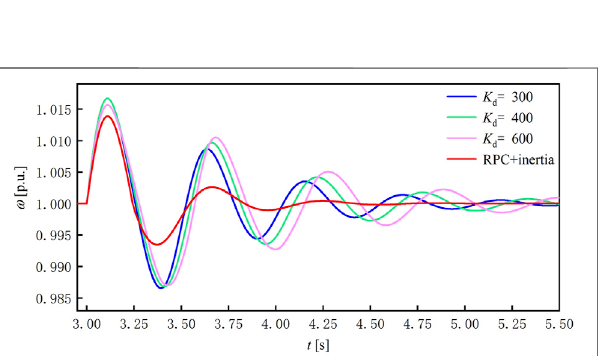
FIGURE 10 | Rotor speed dominated by inertia control modes. FIGURE 11 | Rate of change of rotor speed dominated by inertia